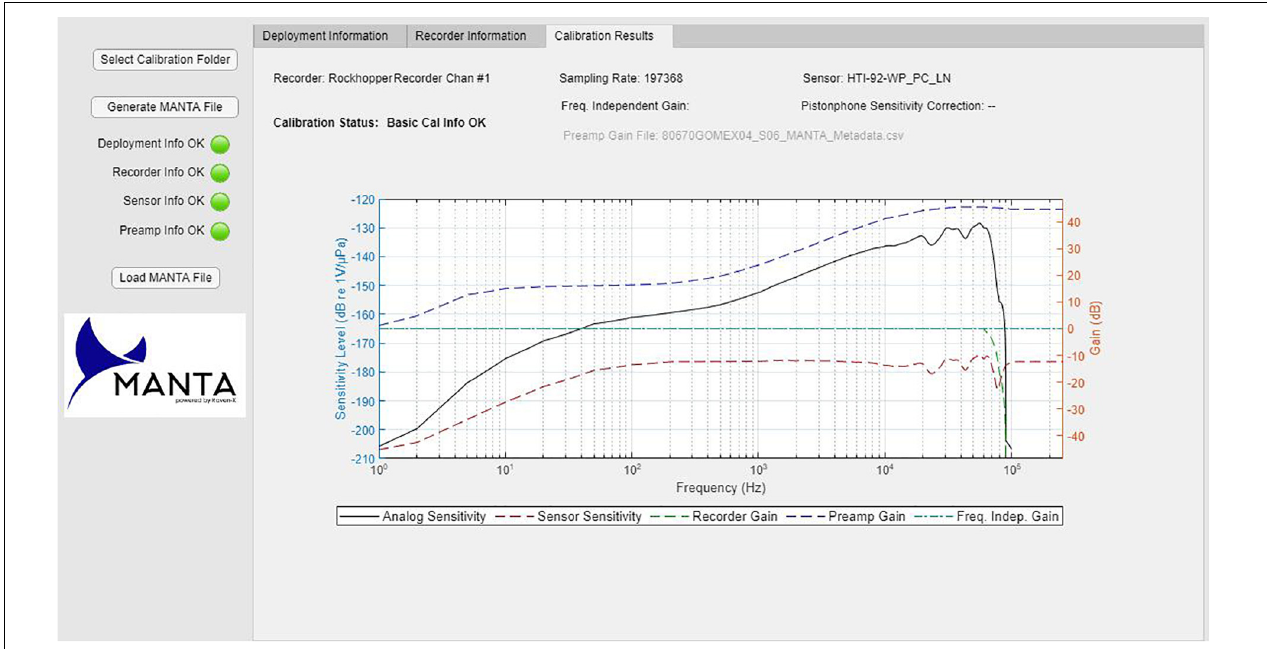
FIGURE 3 | MANTA Metadata Calibration Results. When the deployment, recorder, sensor, and calibration/pre-amp information is fully entered and correct, the four buttons on the left side bar turn green. The calibration output figure is a combination of the user specified calibration including the analog sensitivity, sensor sensitivity, recorder gain, pre-amp gain, and frequency independent